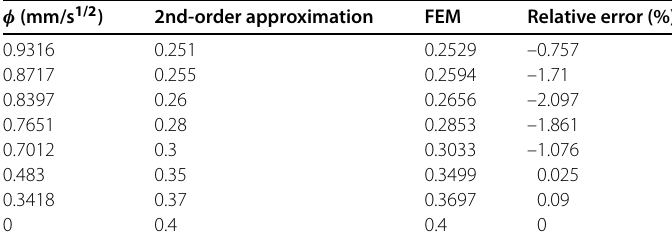
Table 3 Results of θ obtained from the FEM and second-order approximation φ (mm/s 1/2